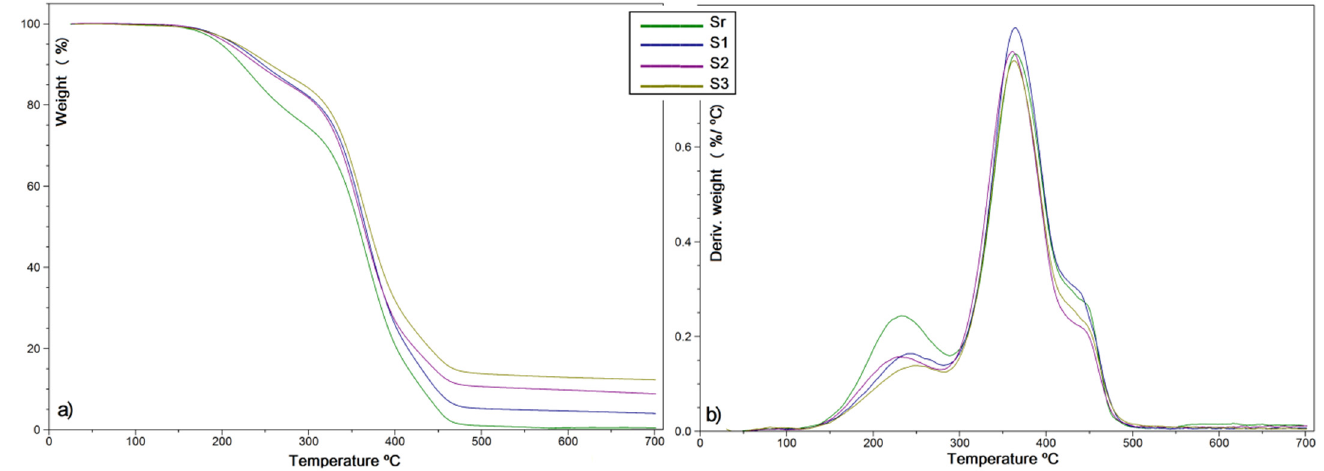
Figure 3. ( a ) TGA and ( b ) DTG curves for ELO-derived composite materials (N 2 ). Table 1. TGA data of ELO and LnK-based products (N 2 and air).